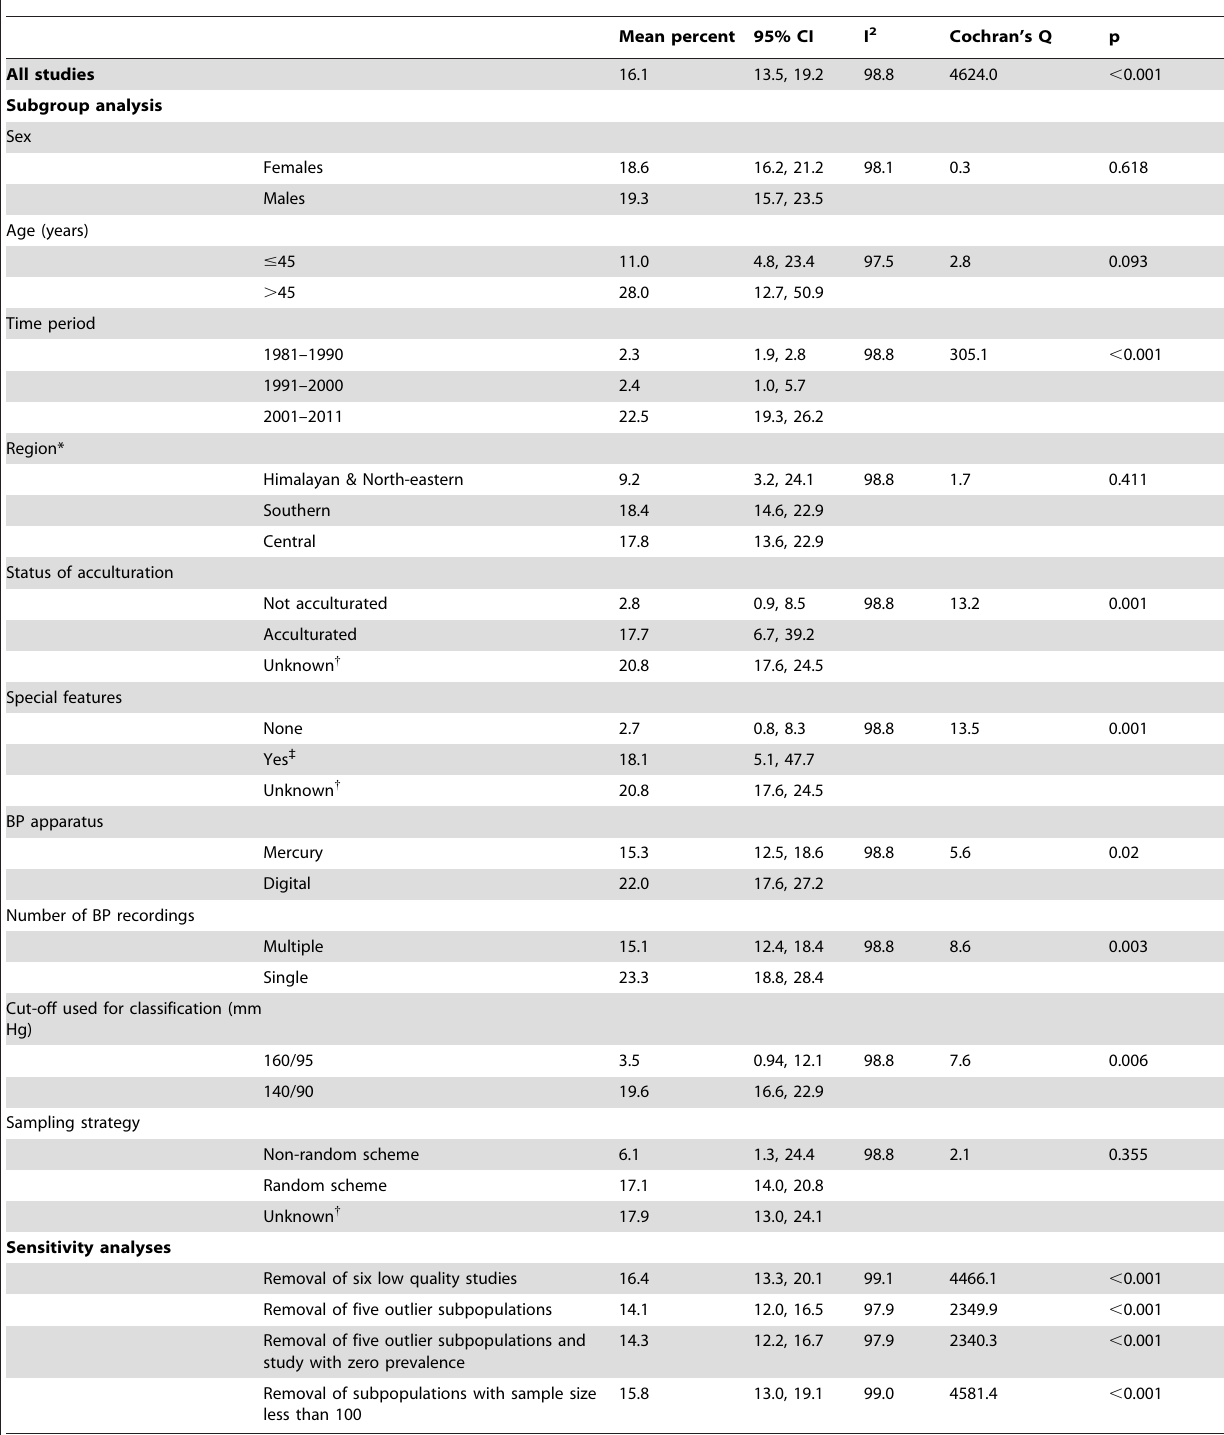
Table 2. Random effects mean percent of hypertension by subgroup and sensitivity